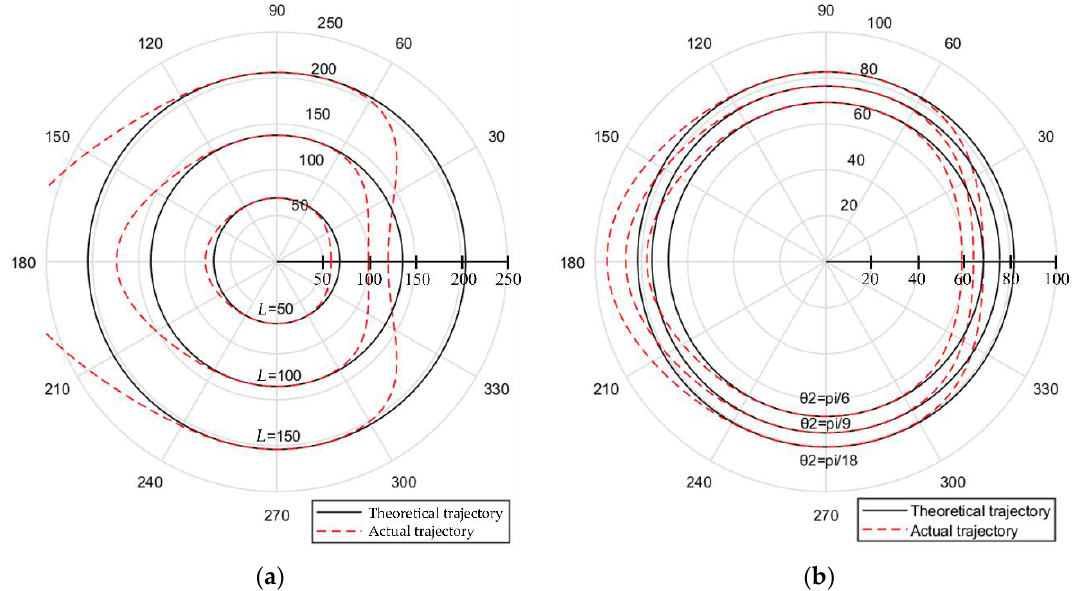
Figure 5. Simulation results of the influence of the second order uniform contraction of ball screw and linear grating on the circular motion trajectory of machine tool. ( a ) The result under different bar lengths. ( b ) The result under different pose angles.